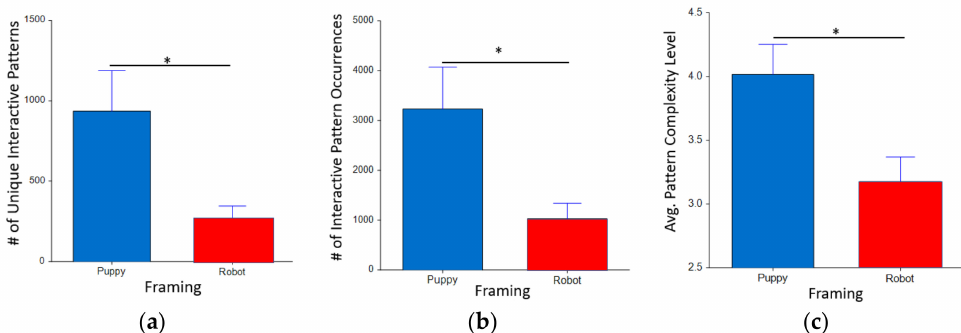
Figure 5. The number of interactive T-patterns and unique T-pattern interactions in each framing condition: ( a ) puppy Aibo led to more interactions compared to robot Aibo; ( b ) Interacting with puppy Aibo led to more unique interactive T-patterns compared to robot Aibo. ( c ) Interacting with puppy Aibo resulted in more complex interactive T-patterns compared to robot Aibo. * p < 0.05.